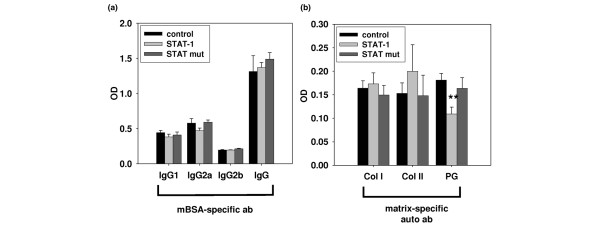
Effects of STAT-1 decoy oligodeoxynucleotide (ODN) treatment on the serum levels of antibodies (ab). (a) Methylated bovine serum albumin(mBSA)-specific IgG isotypes and (b) autoantigen specific IgGs (auto ab) against collagen type I (Col I), collagen type II (Col II) and proteoglycan (PG) in the serum of STAT-1 or STAT mutant (STAT mut) decoy ODN-treated mice 14 days after arthritis induction (n = 8 to 10). **P ≤ 0.01 versus buffer-treated AIA control.